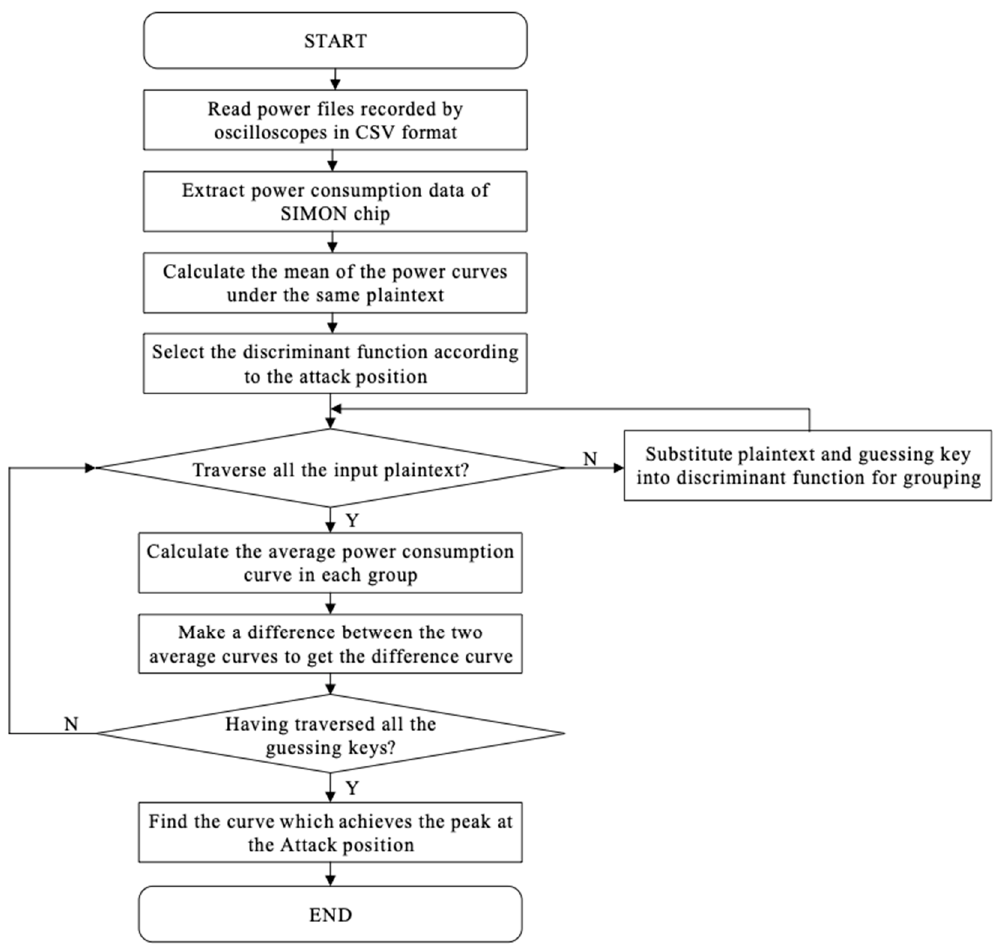
Figure 5. Flow graph of data analysis software.